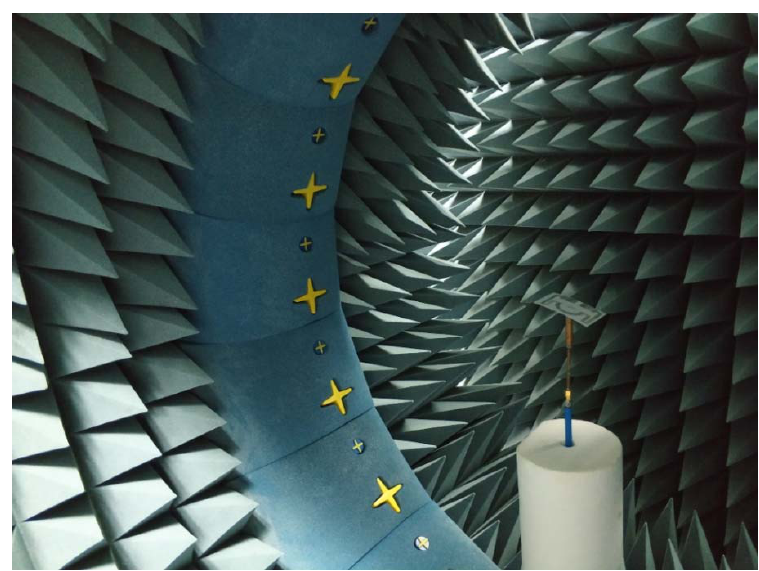
Figure 4. Far-field characteristics measurement using a Satimo near-field measurement system.